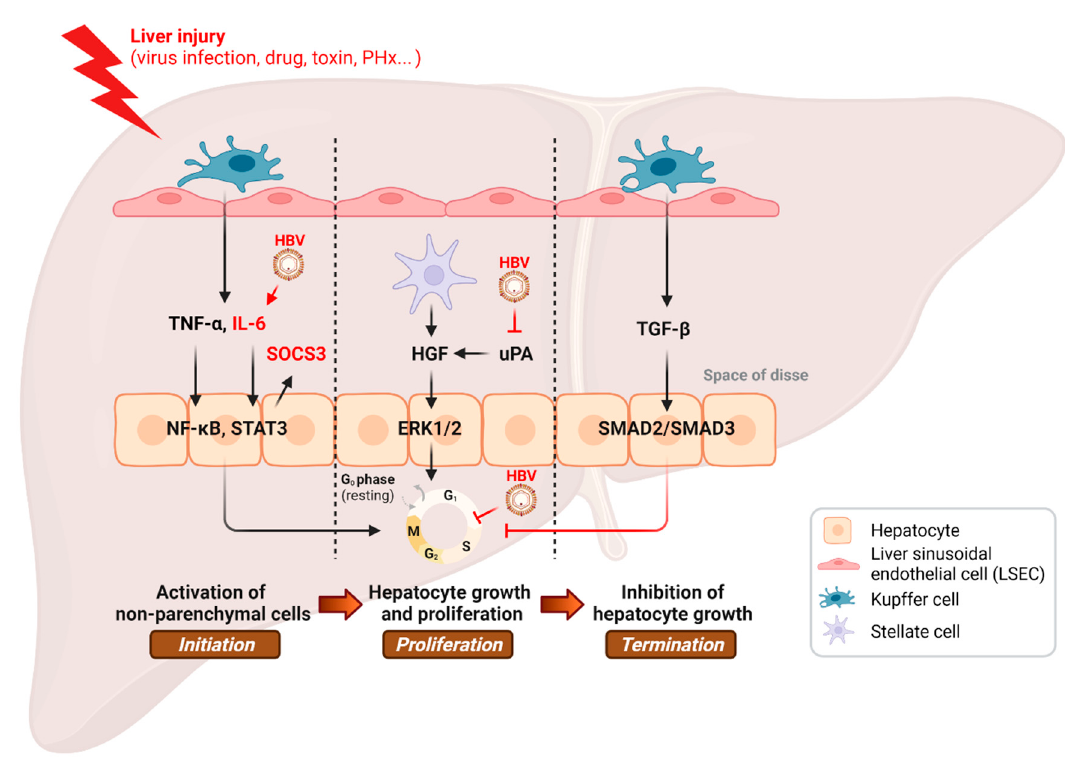
Figure 1. Inhibition of the hepatic regenerative pathway by HBV infection. PHx, partial hepatectomy. This illustration was created with BioRender.com.